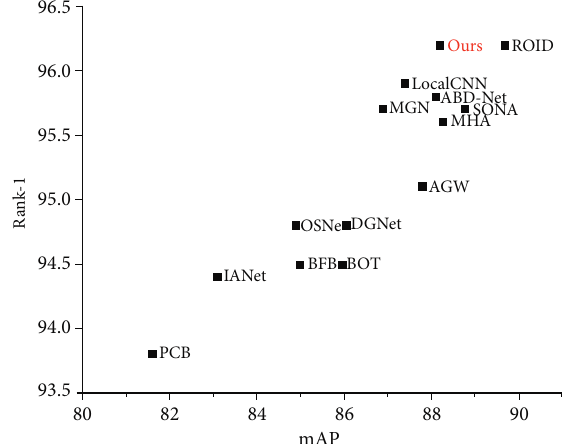
Figure 8: Comparison of indicators between this model and several other Re-ID network models.